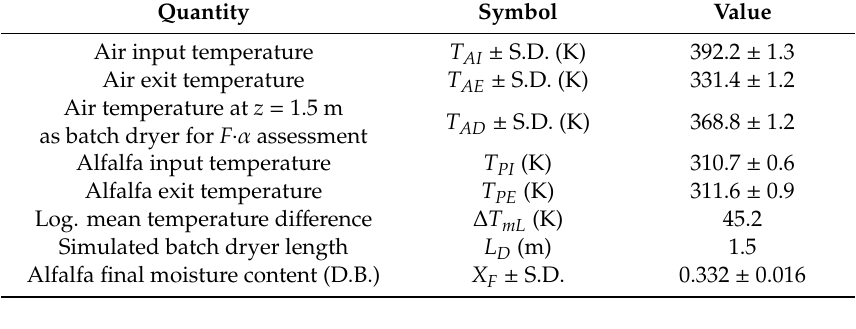
Table 2. Experimental data of the pilot dryer and the batch dryer.